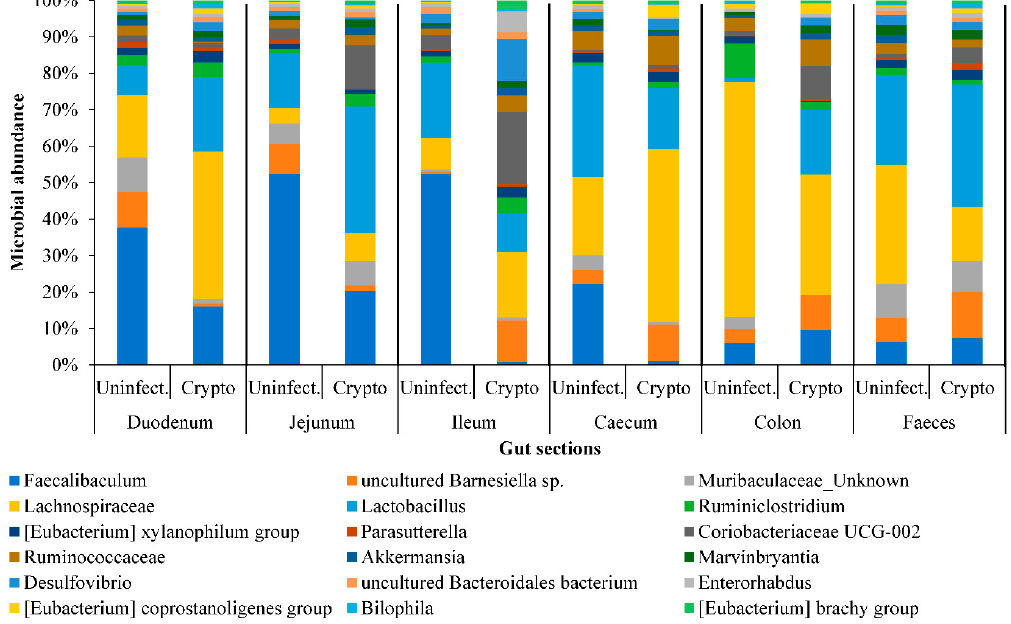
Figure 3. The abundance of predominant bacterial genera across regions of the intestinal system of uninfected and Cryp- tosporidium -infected mice. Individual contribution is presented in Table S1B.